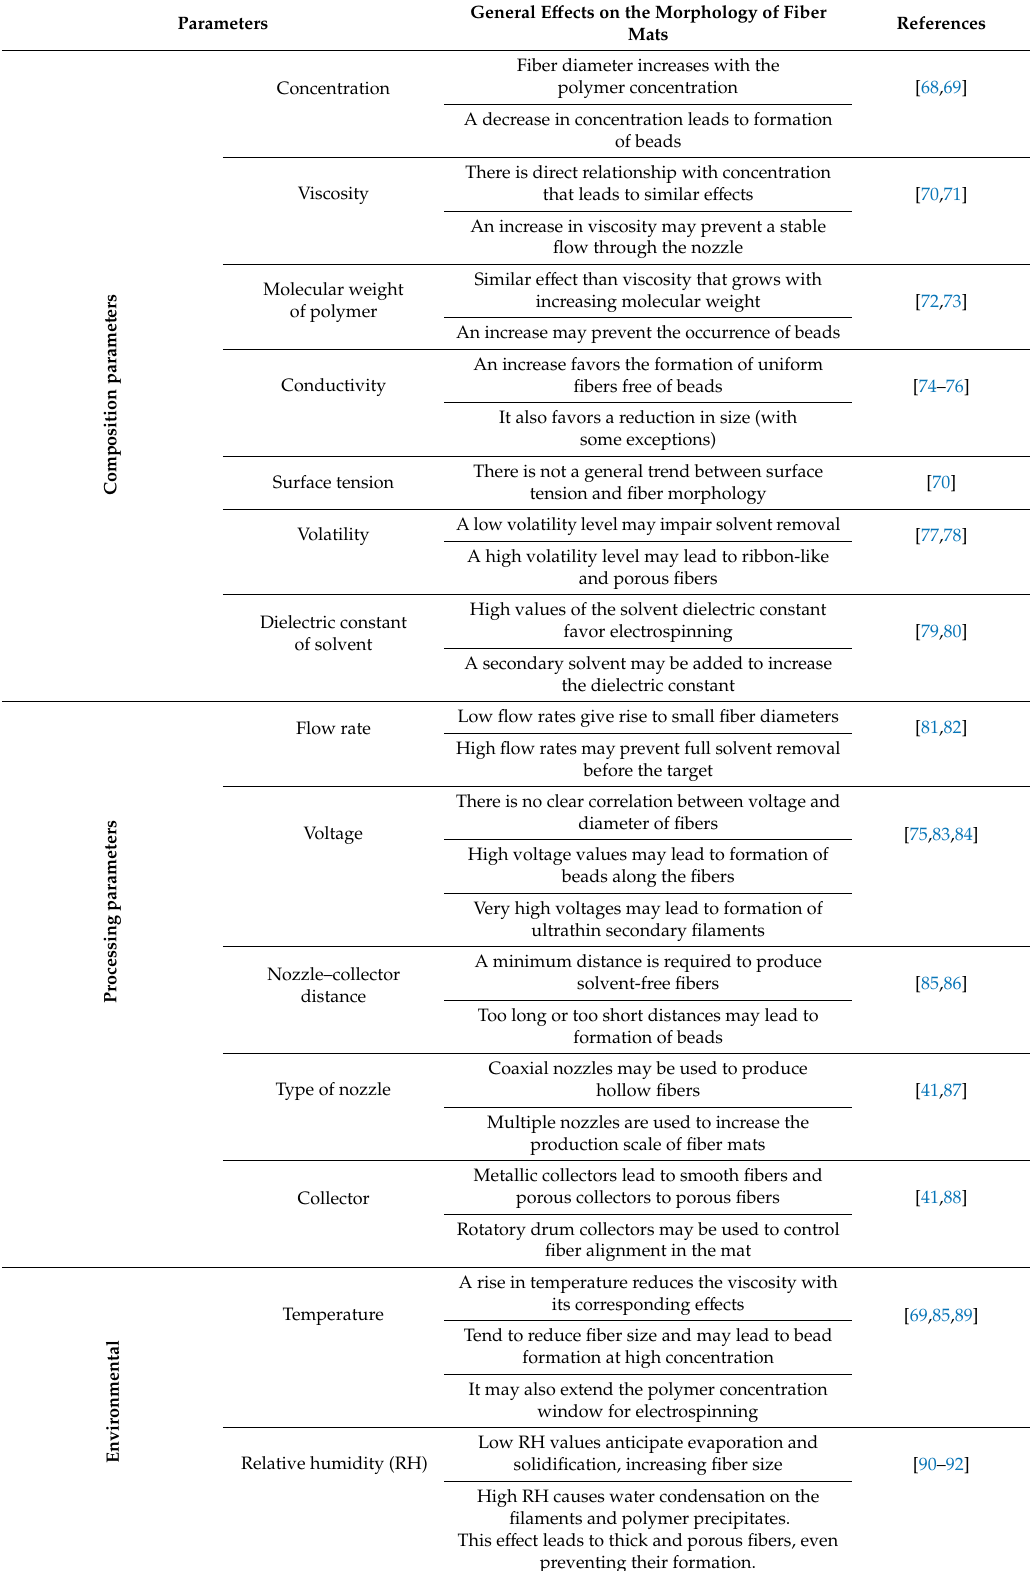
Table 1. Summary of the e ff ects produced by the most important variables of the electrospinning process on the morphology of the fibers